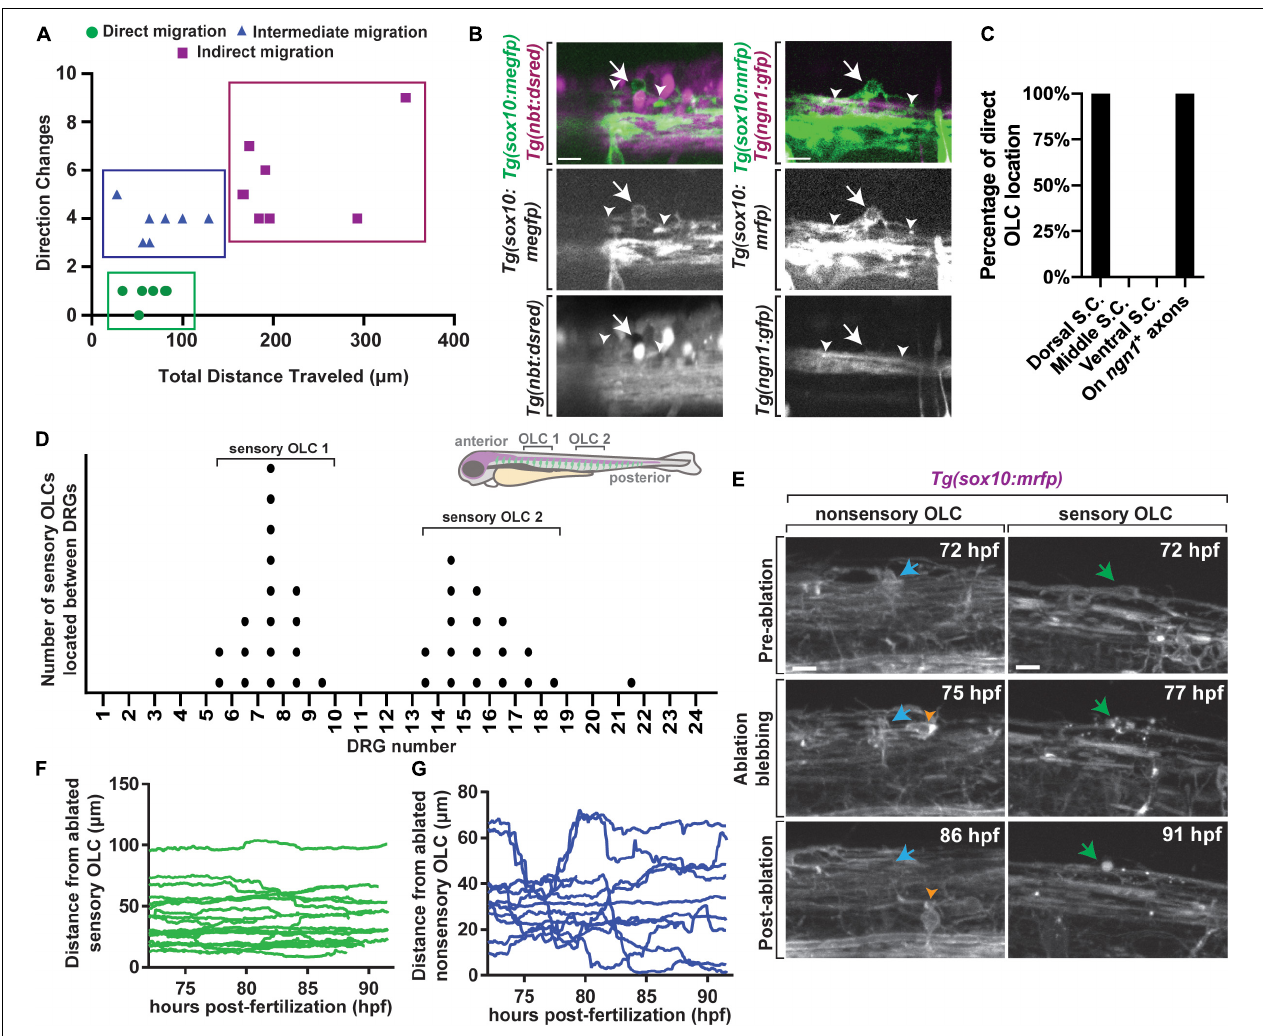
FIGURE 1 | A distinct population of OPCs associates with sensory nerves. (A) Plot of individual OPCs with less direct migration versus individual OPCs with a more direct migration. Green dots denote OPC that migrate less and directly. Blue dots denote OPC with longer distances of migration. (B) Confocal z-stack images from Tg(sox10:megfp);Tg(nbt:dsred) and Tg(ngn1:gfp);Tg(sox10:mrfp) animals at 72 hpf showing that dorsal migrating oligodendrocytes associate specifically with sensory neurons. White arrow represents oligodendrocyte associated with sensory neurons and white arrowheads represent sensory axons. (C) Quantification of the percentage of OLCs located across specific regions in the spinal cord. (D) Quantification of the number of sensory OLs located between specific DRGs. Each point represents one individual sensory OL. Zebrafish diagram in the upper right represents locations of OLC 1 and 2 along the spinal cord. (E) Images from a 24 h time-lapse starting at 72 hpf in Tg(sox10:mrfp) animals showing the ablation of sensory and non-sensory OLs and surrounding OPC response. Blue arrow represents a non-sensory OL. Green arrow represents a sensory OL. Orange arrowheads represent a responding OPC following non-sensory OL ablation. (F) Quantification of the distance surrounding OPCs traveled over time immediately following sensory OL ablation. (G) Quantification of the distance surrounding OPCs traveled over time immediately following non-sensory ablation. Scale bar equals 10 µ m (B,E) . All images are orientated anterior to left, posterior to right, dorsal up and ventral down.